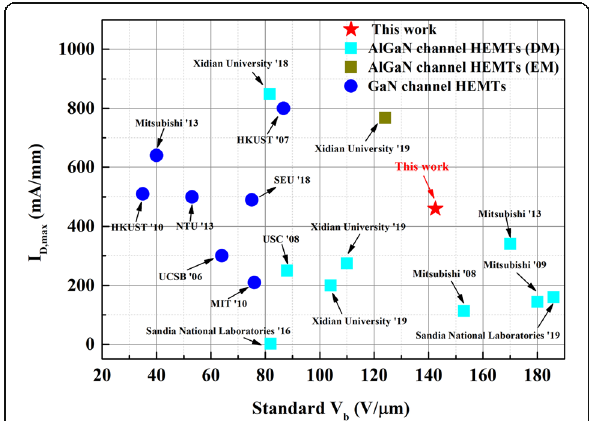
Fig. 8 Benchmark of I max and V b,standard for AlGaN channel and GaN channel HEMTs